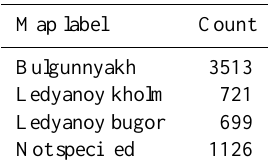
Table 3. Map labels of 6059 pingos identified in topographic maps